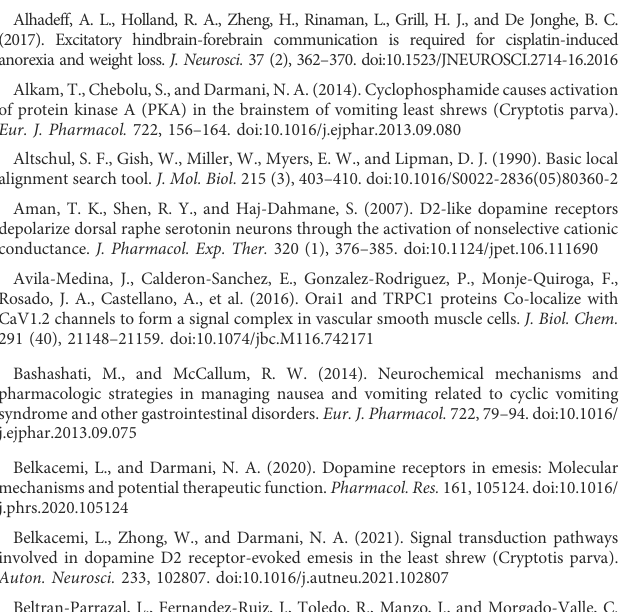
SUPPLEMENTARY TABLE S7 Gene Ontology Enrichment for Candidate Emesis Genes – Molecular Function (All Results). File contains a table with all the signi fi cant molecular process terms in gene ontology enrichment analysis among the candidate genes. SUPPLEMENTARY TABLE S8 Phenotype Enrichment of Top 10% Most Conserved Orthologs. File contains a set of enriched phenotypes with p -values and corrected p-values (FDR, Bonferroni) that are color coded by signi fi cance.